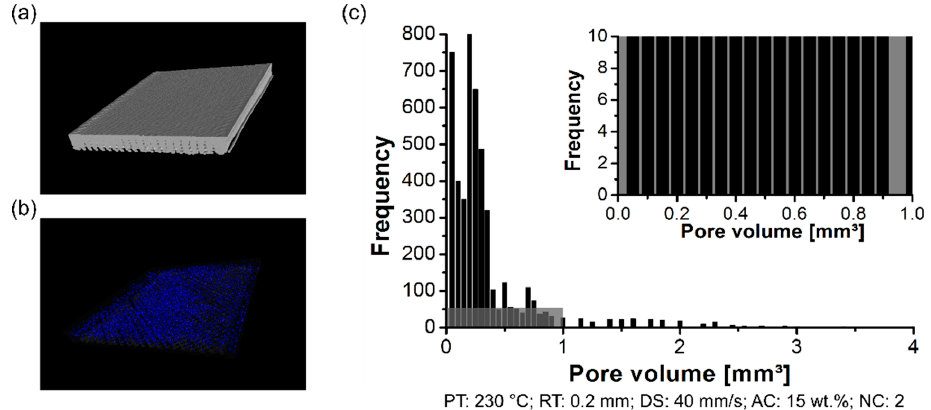
Figure 6. Pore distribution on the 3D ‐ printed ABS for condition one (PT: 230 °C, RT: 0.2 mm, DS: 40 mm/s, AC: 15 wt.%, and NC: 2): ( a ) scanned volume, ( b ) pores distribution, and ( c ) pore volume histogram.